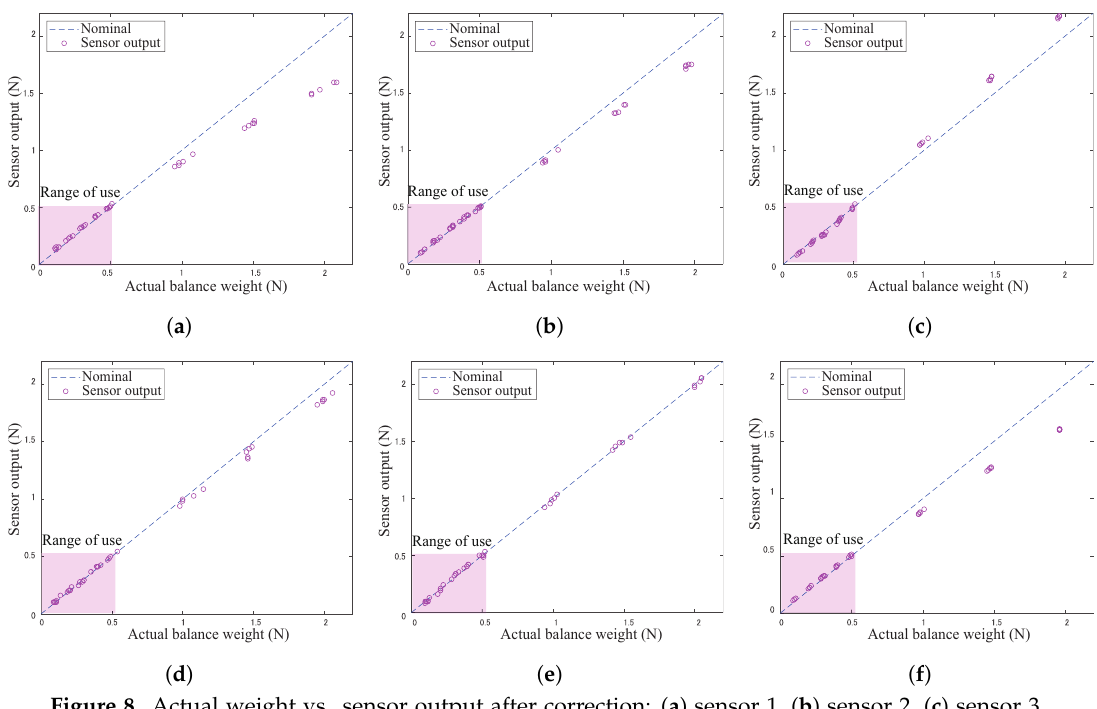
Figure 8. Actual weight vs. sensor output after correction: ( a ) sensor 1, ( b ) sensor 2, ( c ) sensor 3 , ( d ) sensor 4, ( e ) sensor 5, ( f ) sensor 6. The most used range for measuring was below 0.5